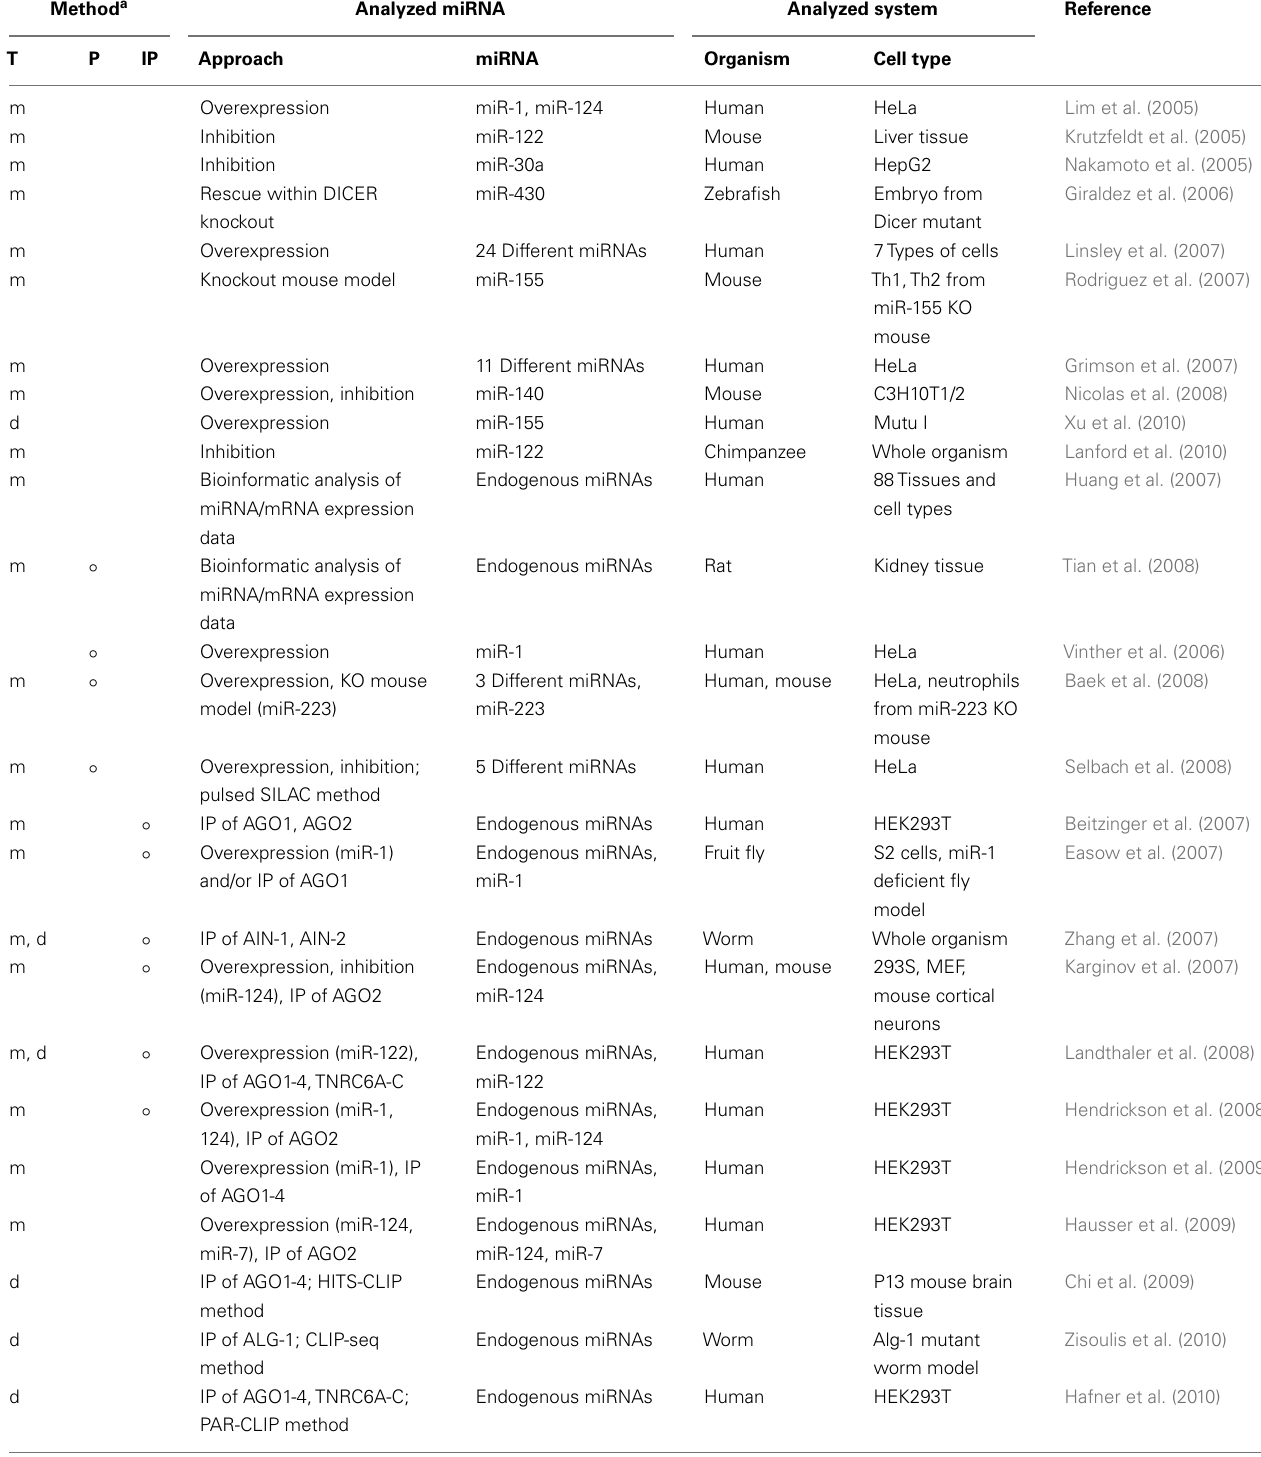
Table 3 | Summary of recent studies using high-throughput approaches to identify miRNA target mRNAs. Method